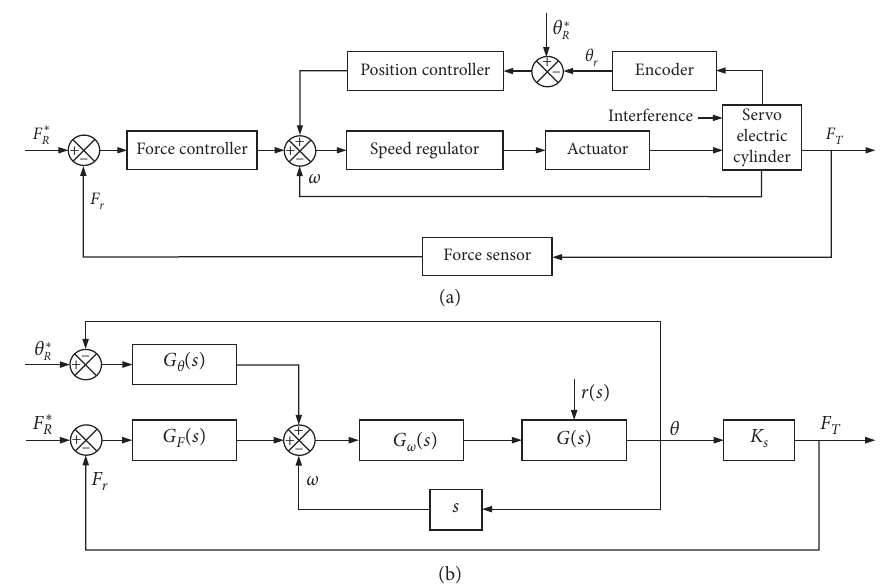
Figure 7: Composite closed-loop control model: (a) composite closed-loop control block; (b) corresponding mathematical